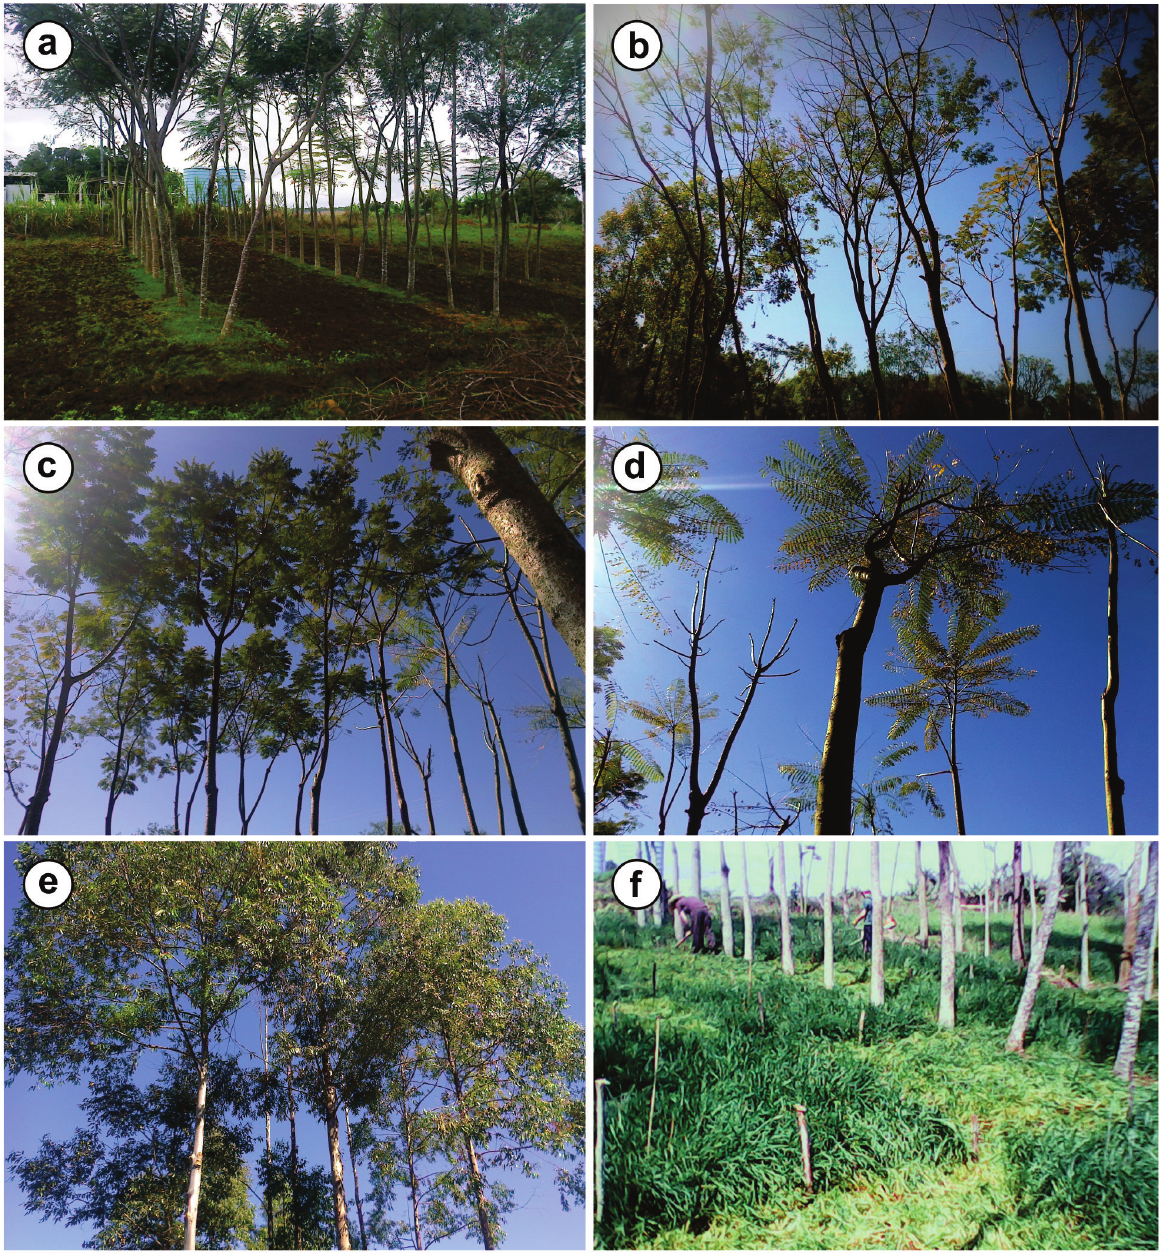
Figure 2 - Agroforestry system among seven years old tree species, with a spacing of 6 or 12 meters between trees, and double purpose wheat ( Triticum aestivum ) with or without grazing simulation (harvesting). Total area prepared for sowing of double purpose wheat (a) ; arboreous canopy of P.rigida (b) , of P.dubium (c) , of S.parahyba (d) , of Eucalyptus (e) , and simulation of double purpose wheat grazing (approximately 10 cm above the soil) consortium with P.dubium after three months of sowing (f)